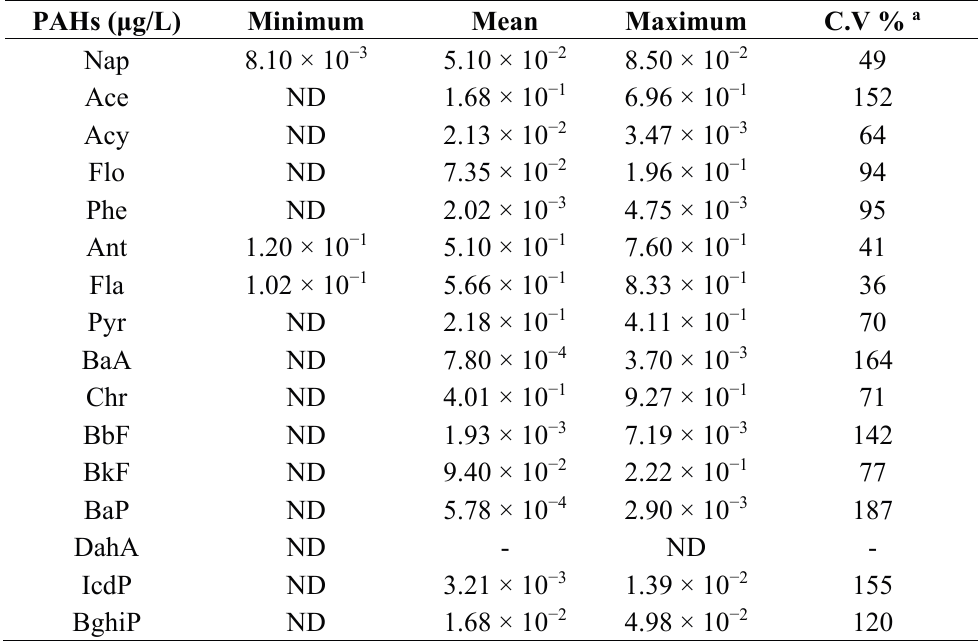
Table 2. The concentration levels of 16 PAHs in the water.